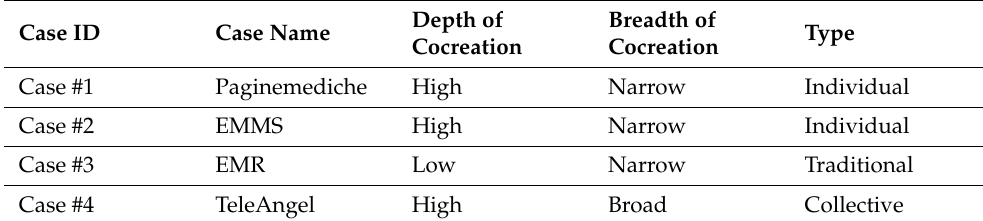
Table 8. Depth and breadth of